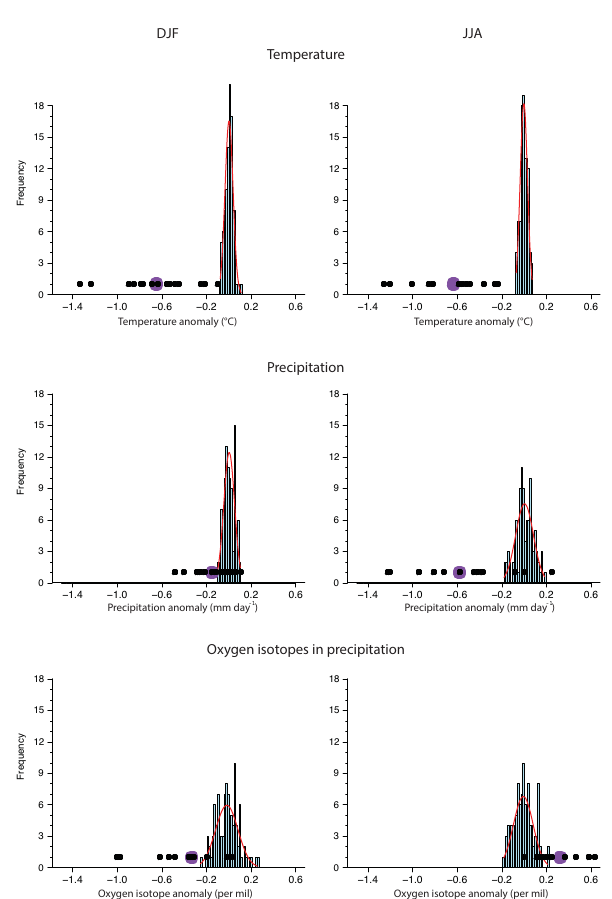
Figure 12. Frequency distribution of 100 random 45-event compos- ites in LM control simulation of ModelE2-R (blue) for temperature (top row), precipitation (middle), and oxygen isotopes in precipita- tion (bottom) for DJF (left column) and JJA (right column). Results averaged over same domains as in Fig. 9. Normal distribution with a mean and standard deviation equal to that of the data shown in red. Purple square shows the single 45-event composite used in this study, with the distribution of individual 15 volcanic eruptions (each averaged over three ensemble members) in black